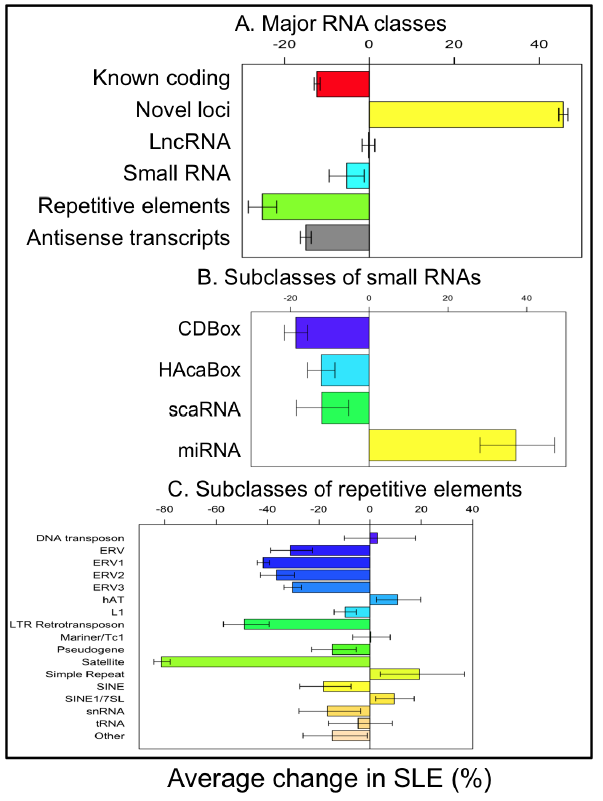
Figure 2. Differential expression of RNA classes. A) The average transcriptional changes of five RNA classes in SLE. B) The average transcriptional change of four sub-classes of small RNAs in SLE. C) The average transcriptional change of 17 subclasses of repetitive elements in SLE. The eight control and nine SLE libraries were used for this analysis. Error bars indicate standard